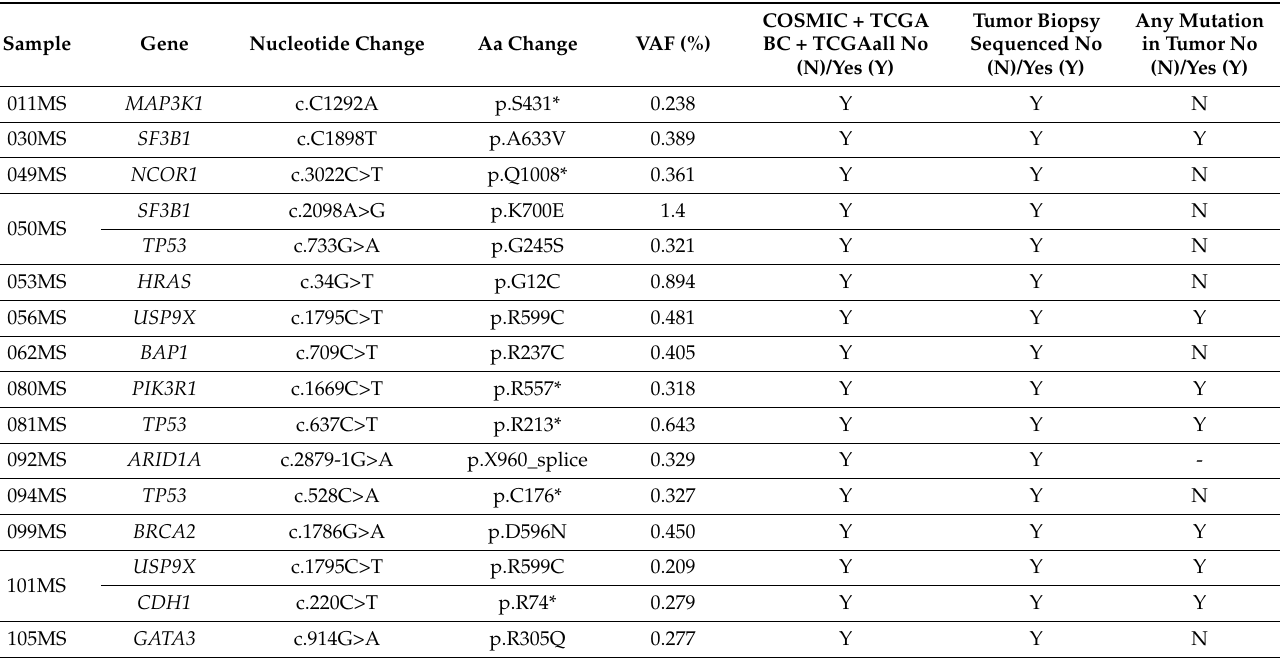
Table 3. Mutations detected exclusively in plasma samples. It is indicated whether the mutations are described in databases (COSMIC and TCGA) as well as whether the tumor biopsy was sequenced and any mutation was